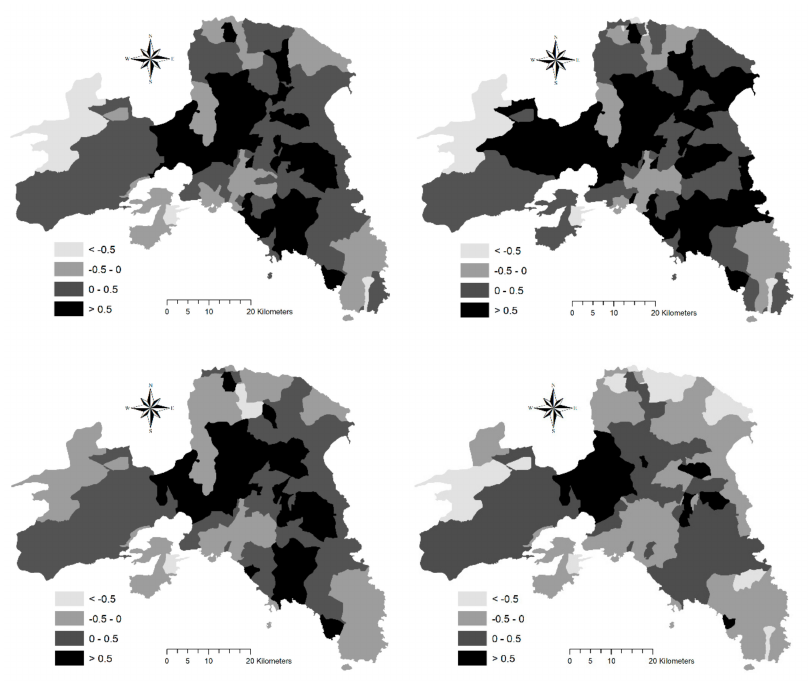
Figure 9. Annual natural rate of population growth (%) by municipality and time interval. upper line : ( left ) 1999–2003 and ( right ) 2004–2008; lower line ( left ) 2009–2013 and ( right )